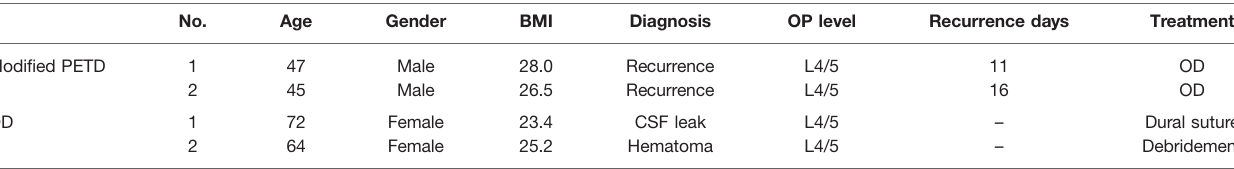
TABLE 2 | Recurrence and